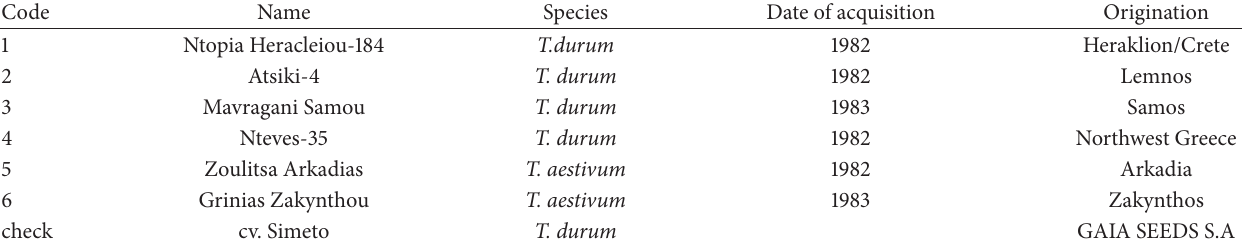
Table 1: Wheat ( Triticum spp.) landraces and the check cultivar used.